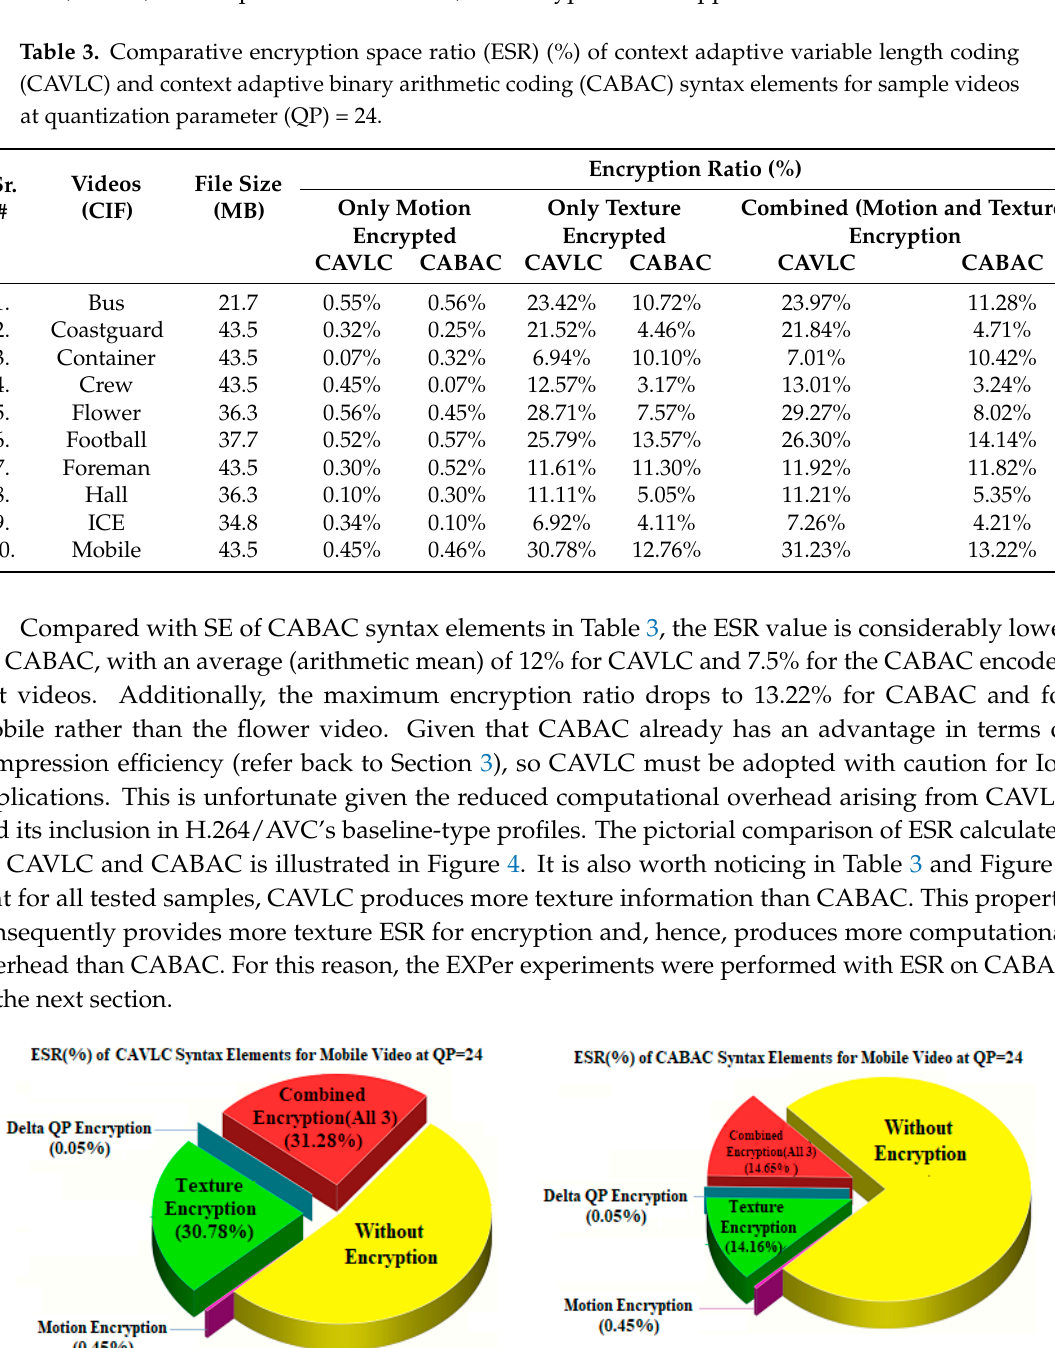
Table 3. Comparative encryption space ratio (ESR) (%) of context adaptive variable length coding